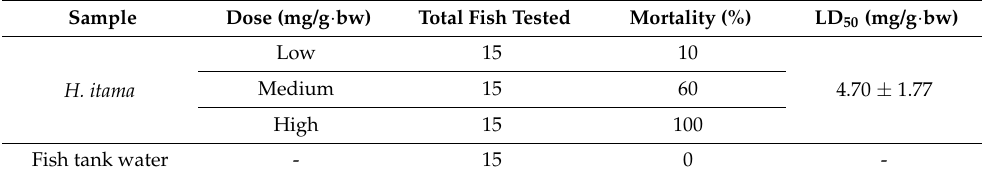
Table 3. Acute toxicity test of pure honey H. itama in adult zebrafish ( Danio rerio ).